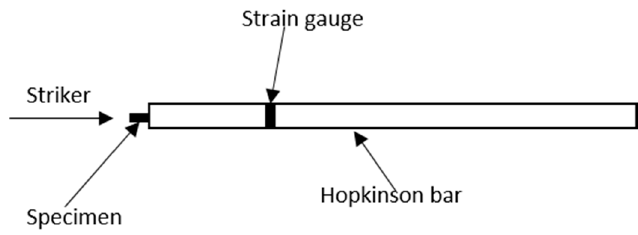
Figure 11. Configuration of split Hopkinson bar technique.